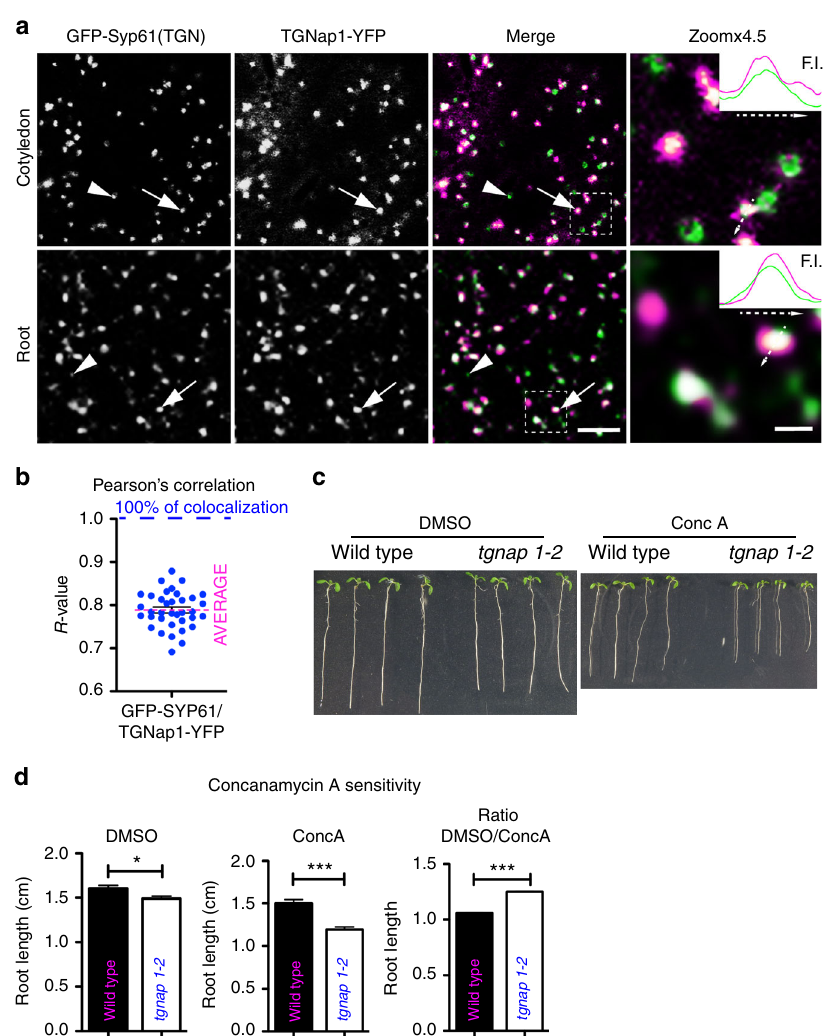
Fig. 3 TGNap1 is a functional TGN protein. a Confocal images of epidermal cells coexpressing GFP-Syp61 and TGNap1-YFP (respectively, green and magenta, in white overlapping regions, single panels in grayscale). Arrows: TGNs positive for both GFP-Syp61 and TGNap1-YFP; arrowheads: Syp61- positive TGNs devoid of TGNap1-YFP signal. Scale bar = 5 µ m. Zoomx4.5 panels: 4.5x magni fi cation of the regions marked in merge (white dashed lines). Scale bar = 1 µ m. Insets: intensity pro fi le (F.I.) measurements for GFP-Syp61 (green) and TGNap1-YFP (magenta) along the arrow on individual TGNs, indicating non-complete overlap of the two signals. b Pearson ’ s correlation coef fi cient ( R -value: 78.85%; n = 36). c Images of WT and tgnap1 – 2 seedlings grown on DMSO or 50 nM ConcA-containing media. d Primary root length and relative ratio. Measurements from three independent experiments. Error bars indicate S.E.M; Student t -test was applied, p -values are represented by asterisks when signi fi cantly different from the corresponding control: *0.01 > p < 0.05; *** p < 0.001. Source data provided as a Source Data fi